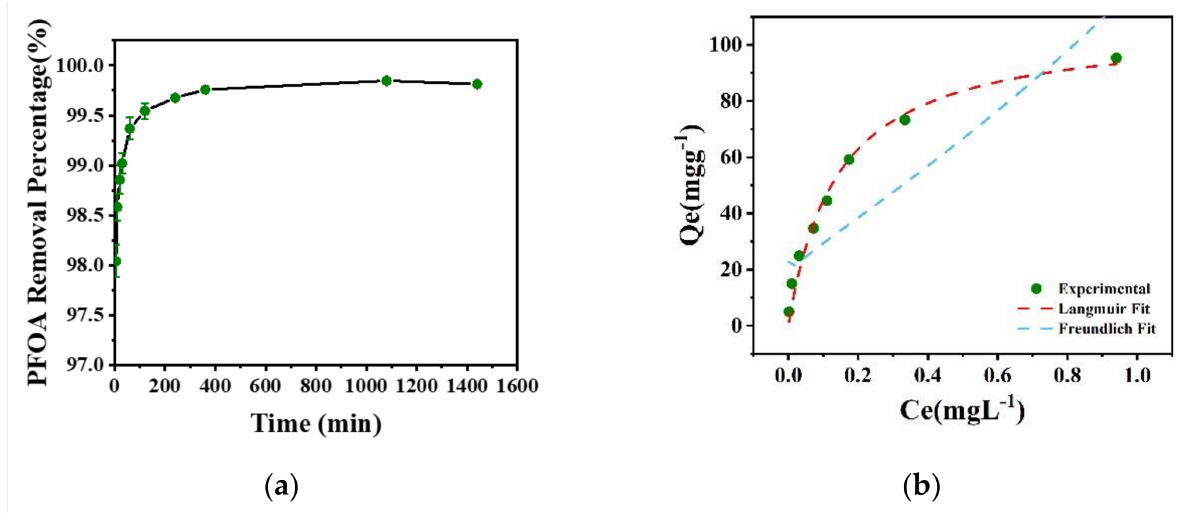
Figure 5. ( a ) Kinetics of PFOA adsorption by POP-4F ([PFOA] 0 = 1 mg L − 1 ; [POP-4F] = 200 mg L − 1 ) at 25 ◦ C; ( b ) Isotherm of PFOA adsorption by POP-4F ([PFOA] 0 = 1 − 20 mg L − 1 ; [POP-4F] = 200 mg L − 1 ) at 25 ◦ C. The lines are Langmuir (red) and Freundlich (blue) fitted curves. Error bars: standard deviation of three